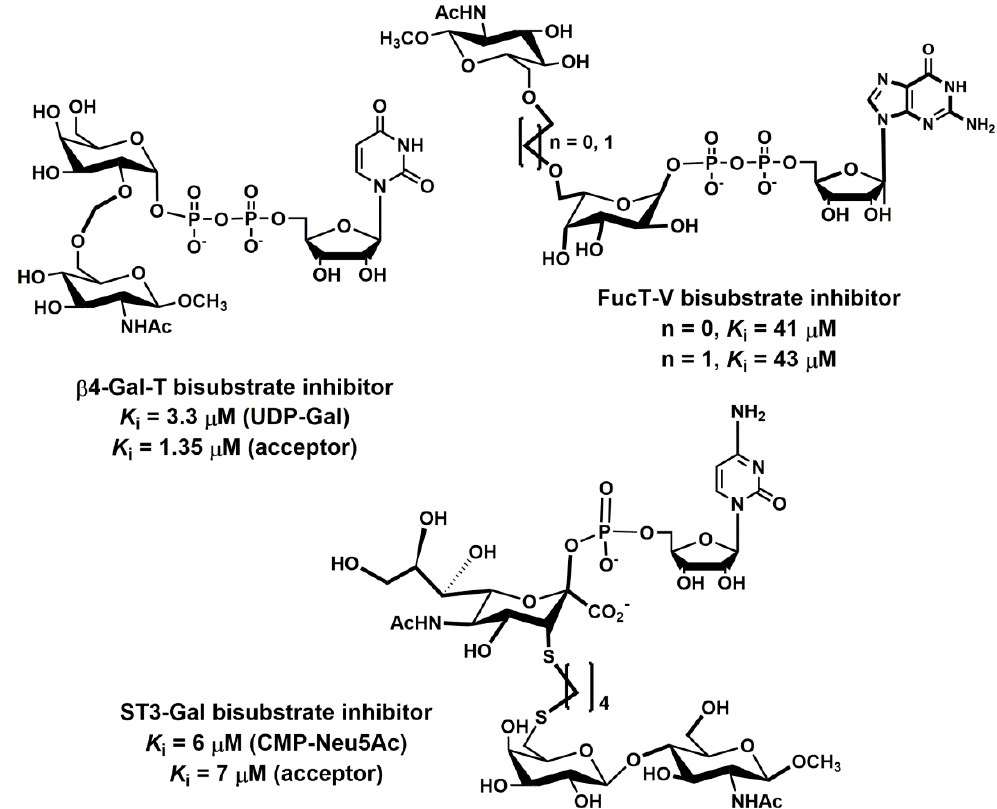
Figure 19. Schematic representation of selected bisubstrate analog inhibitors.